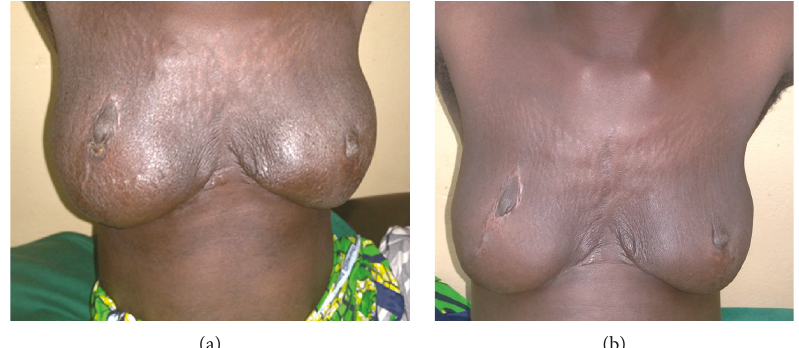
Figure 3: (a) Aesthetic result at 2 months (minimal lymphangitis). (b) Aesthetic result at 18